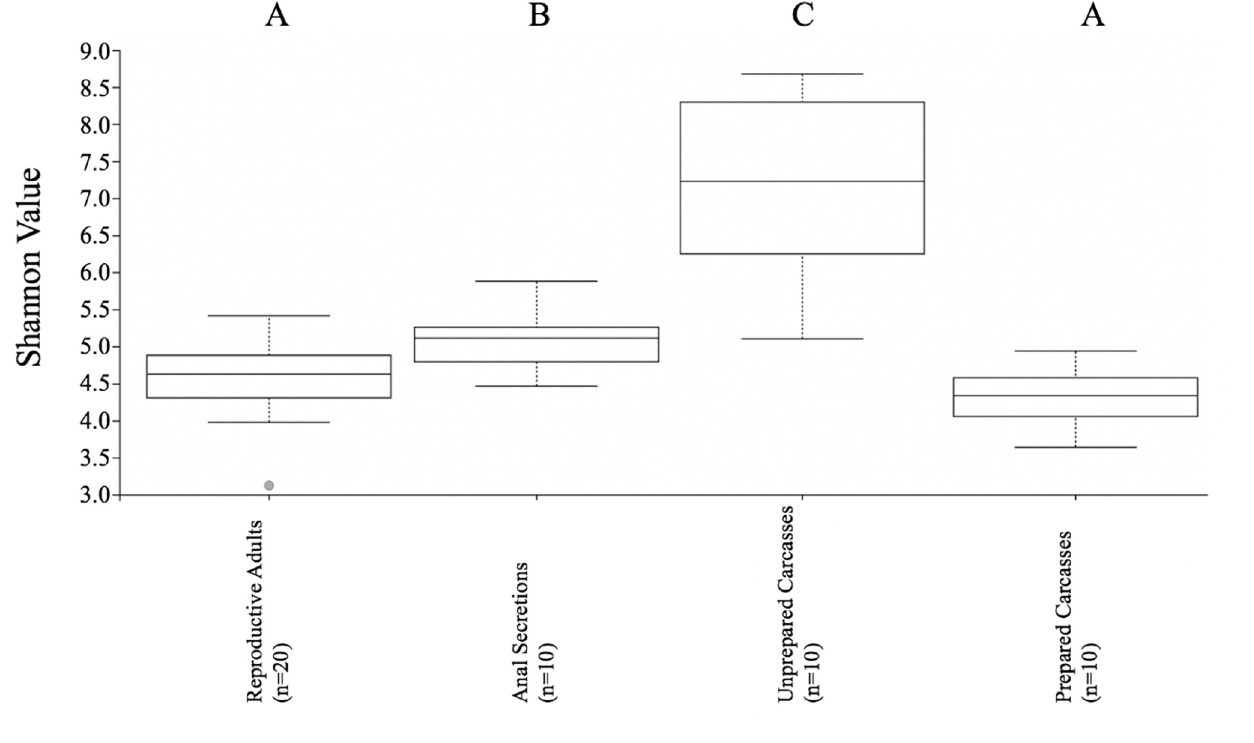
Fig 2. Sample alpha diversity. Box plots depict Shannon-Weiner values compared with pairwise Kruskal-Wallis analysis. Letters designate significantly different groups ( p < 0.05).